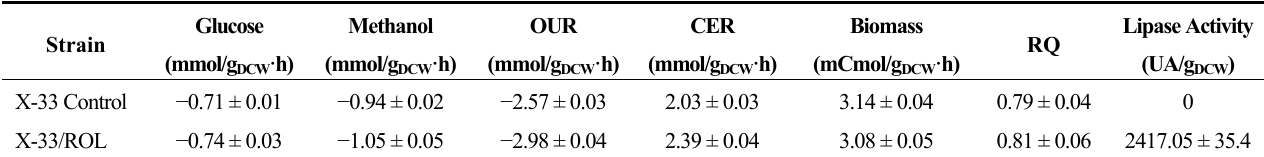
Table 1. Reconciled specific uptake and production rates of P. pastoris growing in chemostat cultures ( D = 0.09 h  1 ) with glucose/methanol substrate mixture. The calculations and standard deviations are based on triplicate measurements; RQ, Respiratory